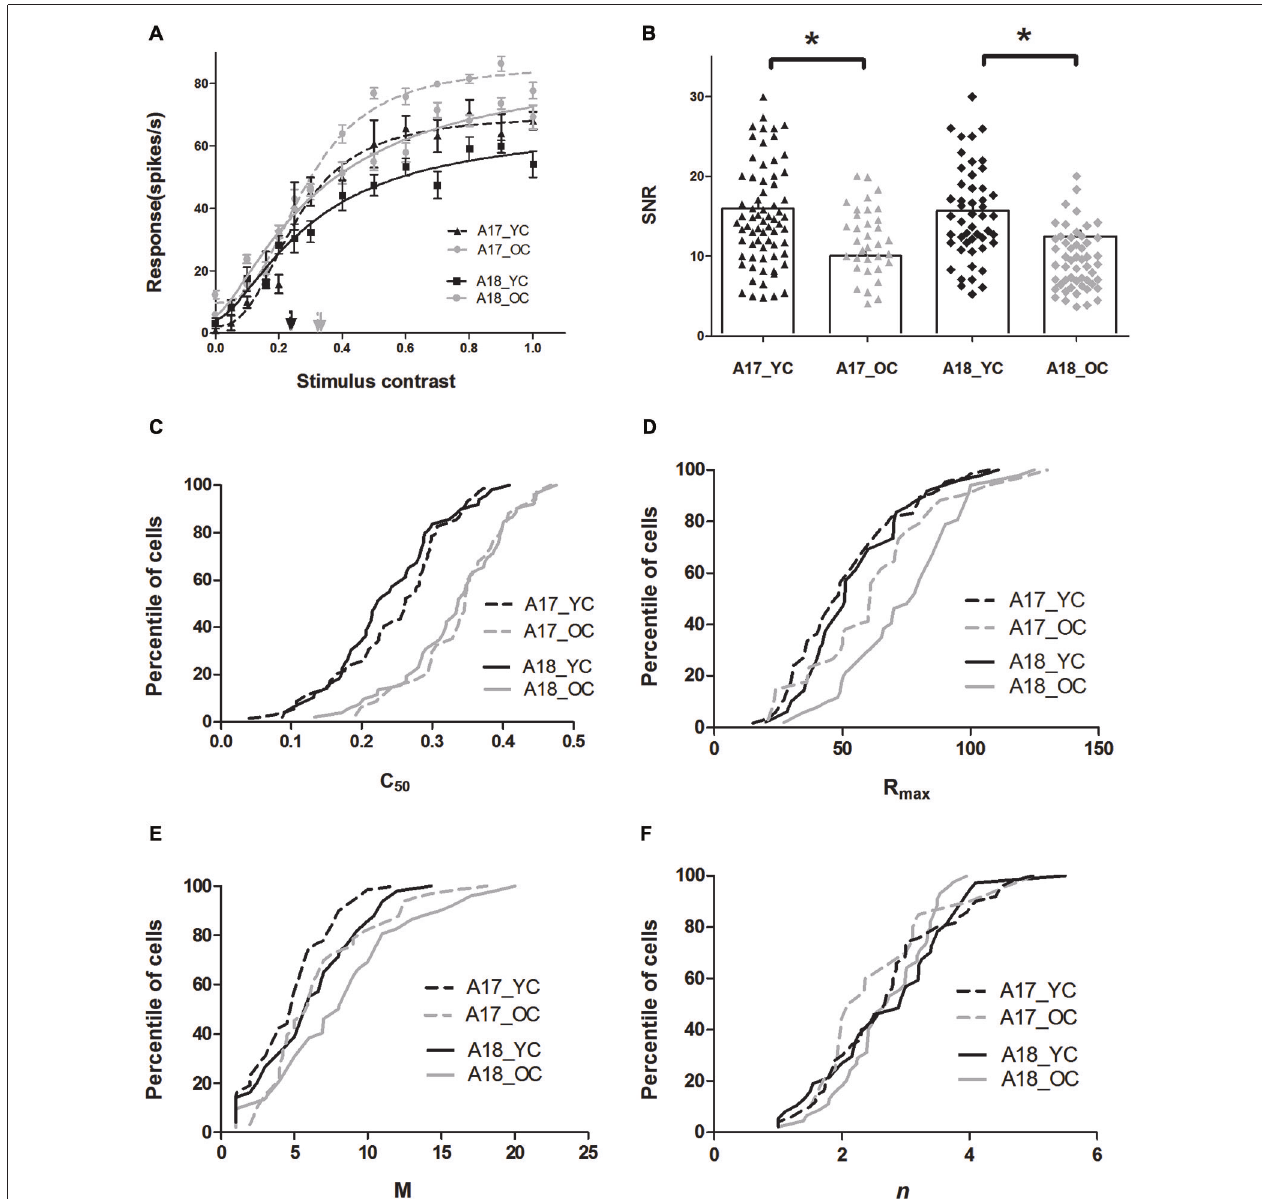
FIGURE 2 | Contrast response properties of A17 and A18 neurons in young and old cats. (A) Example curve fit for contrast response functions (CRFs) of typical young neurons (black line) and typical old neurons (gray line) recorded from A17 (dotted lines) and A18 (solid lines) neurons. Each point represents the response to the stimulus at a given contrast. The fitted curves take the form of a Naka-Rushton function with the C 50 values marked with black (YC) and gray (OC) arrows.